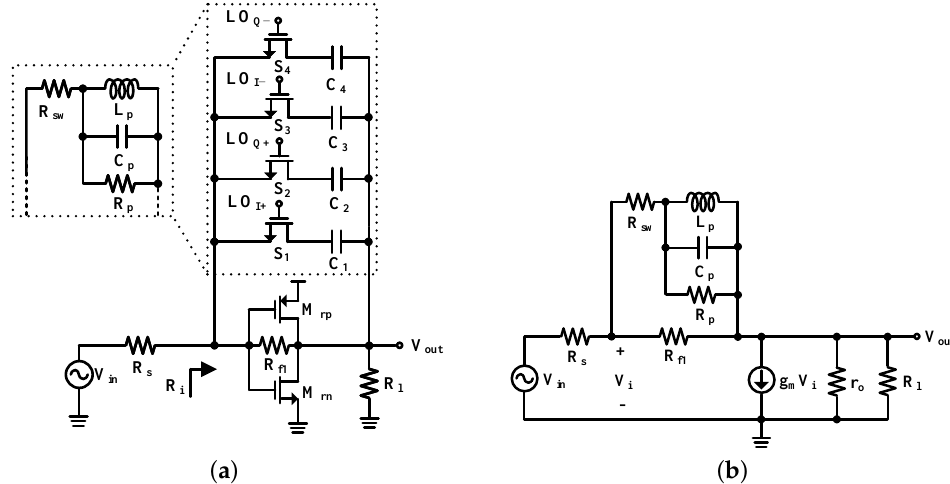
Figure 4. ( a ) Proposed LNA with an NPSC network and its equivalent RLC circuit. ( b ) Small-signal equivalent